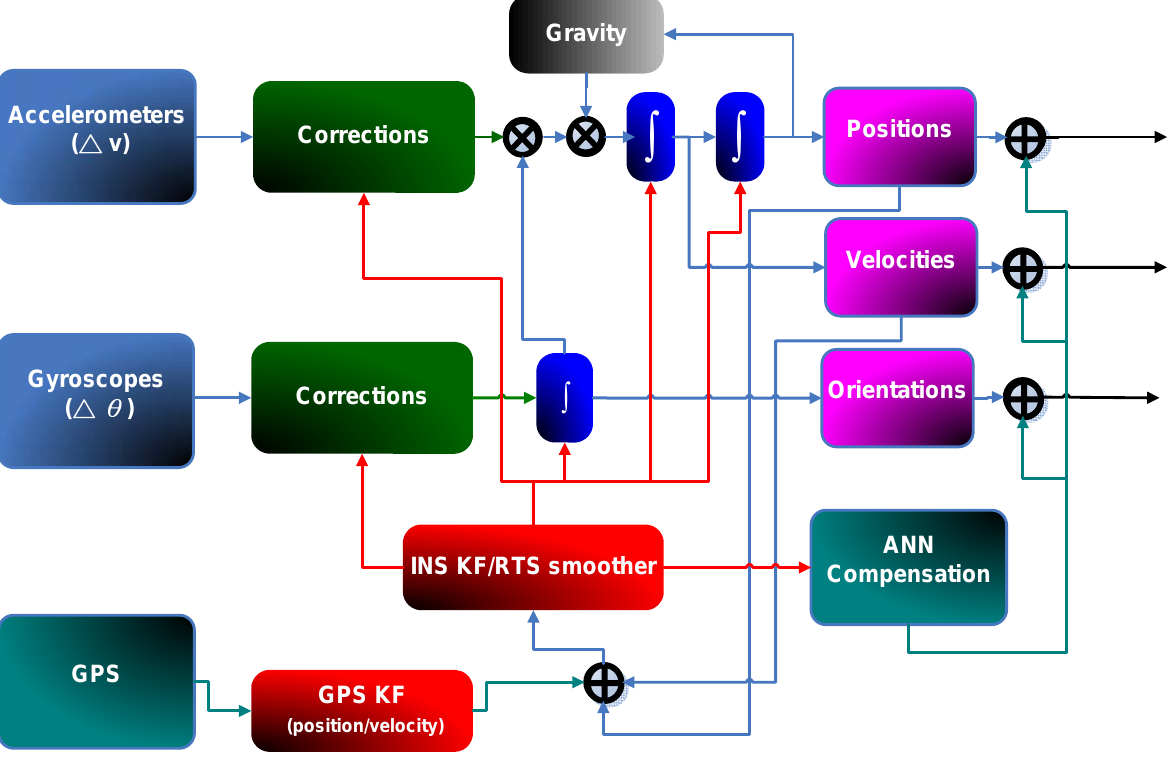
Figure 8. The implementation of ANN embedded KF and RTS